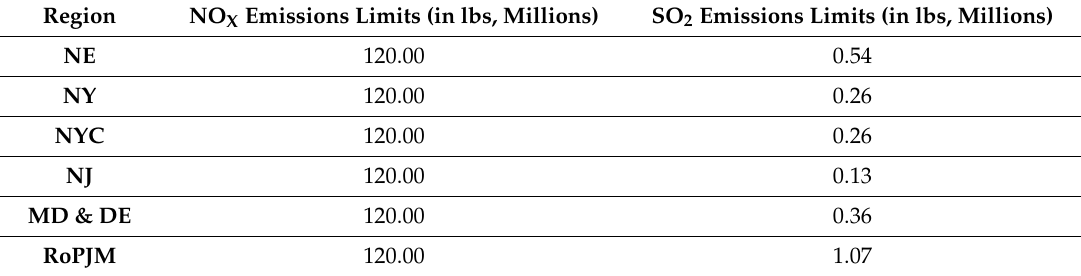
Table A7. Regional Emissions Limits (U.S. Environmental Protection Agency, 2013).